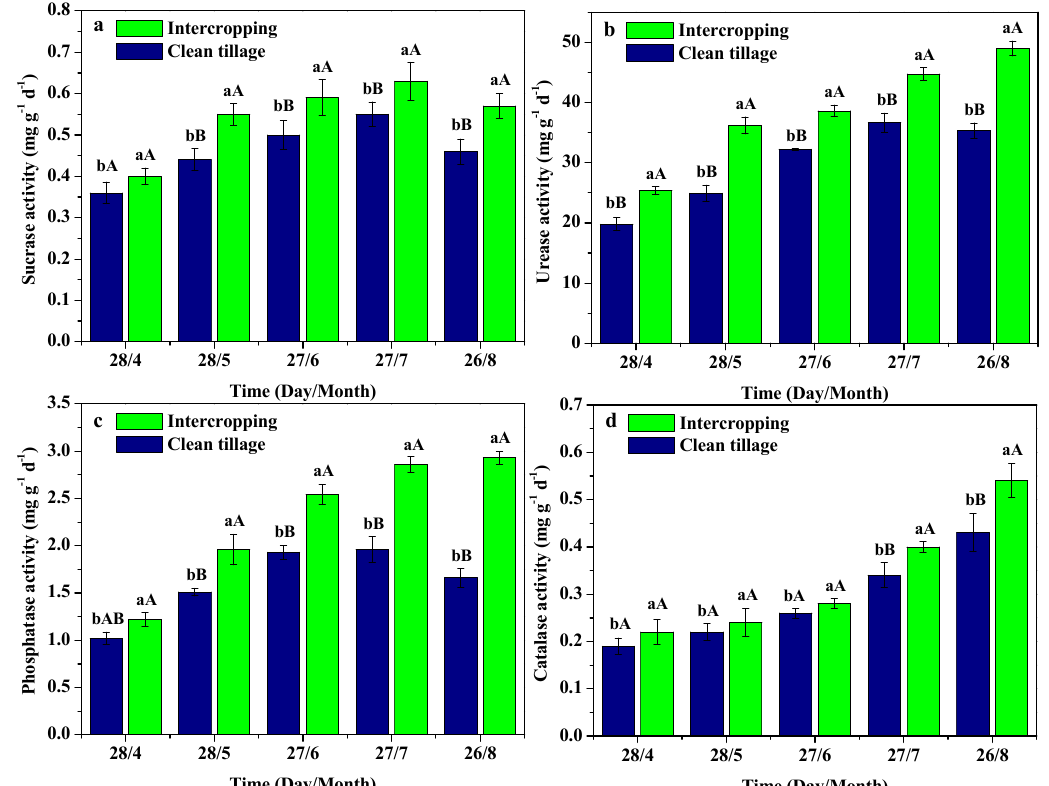
Figure 2. Effects of intercropping V. sativa on sucrase ( a ), urease ( b ), phosphatase ( c ), and catalase ( d ) activities of soils in young kiwifruit orchard. Values and error bars indicate the mean and SD of three replicates, respectively. Different small and capital letters in the same period indicate significant differences at 5% level ( p < 0.05) and 1 % level ( p < 0.01) between intercropping and clean tillage, respectively.